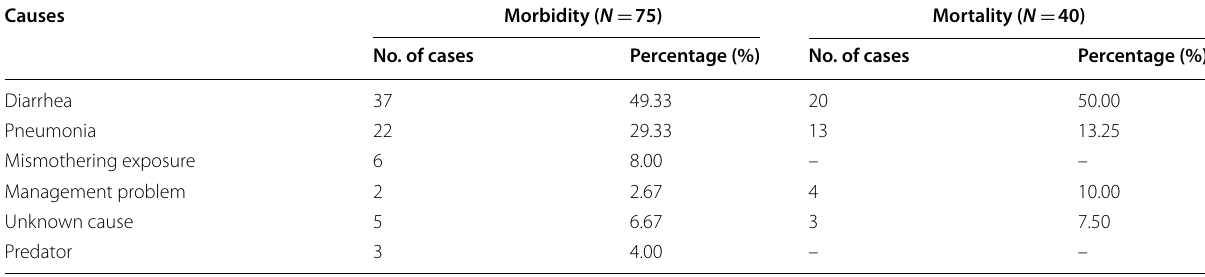
Table 4 Major causes of morbidity and mortality in the 408-lamb monitored in southwestern Ethiopia Causes